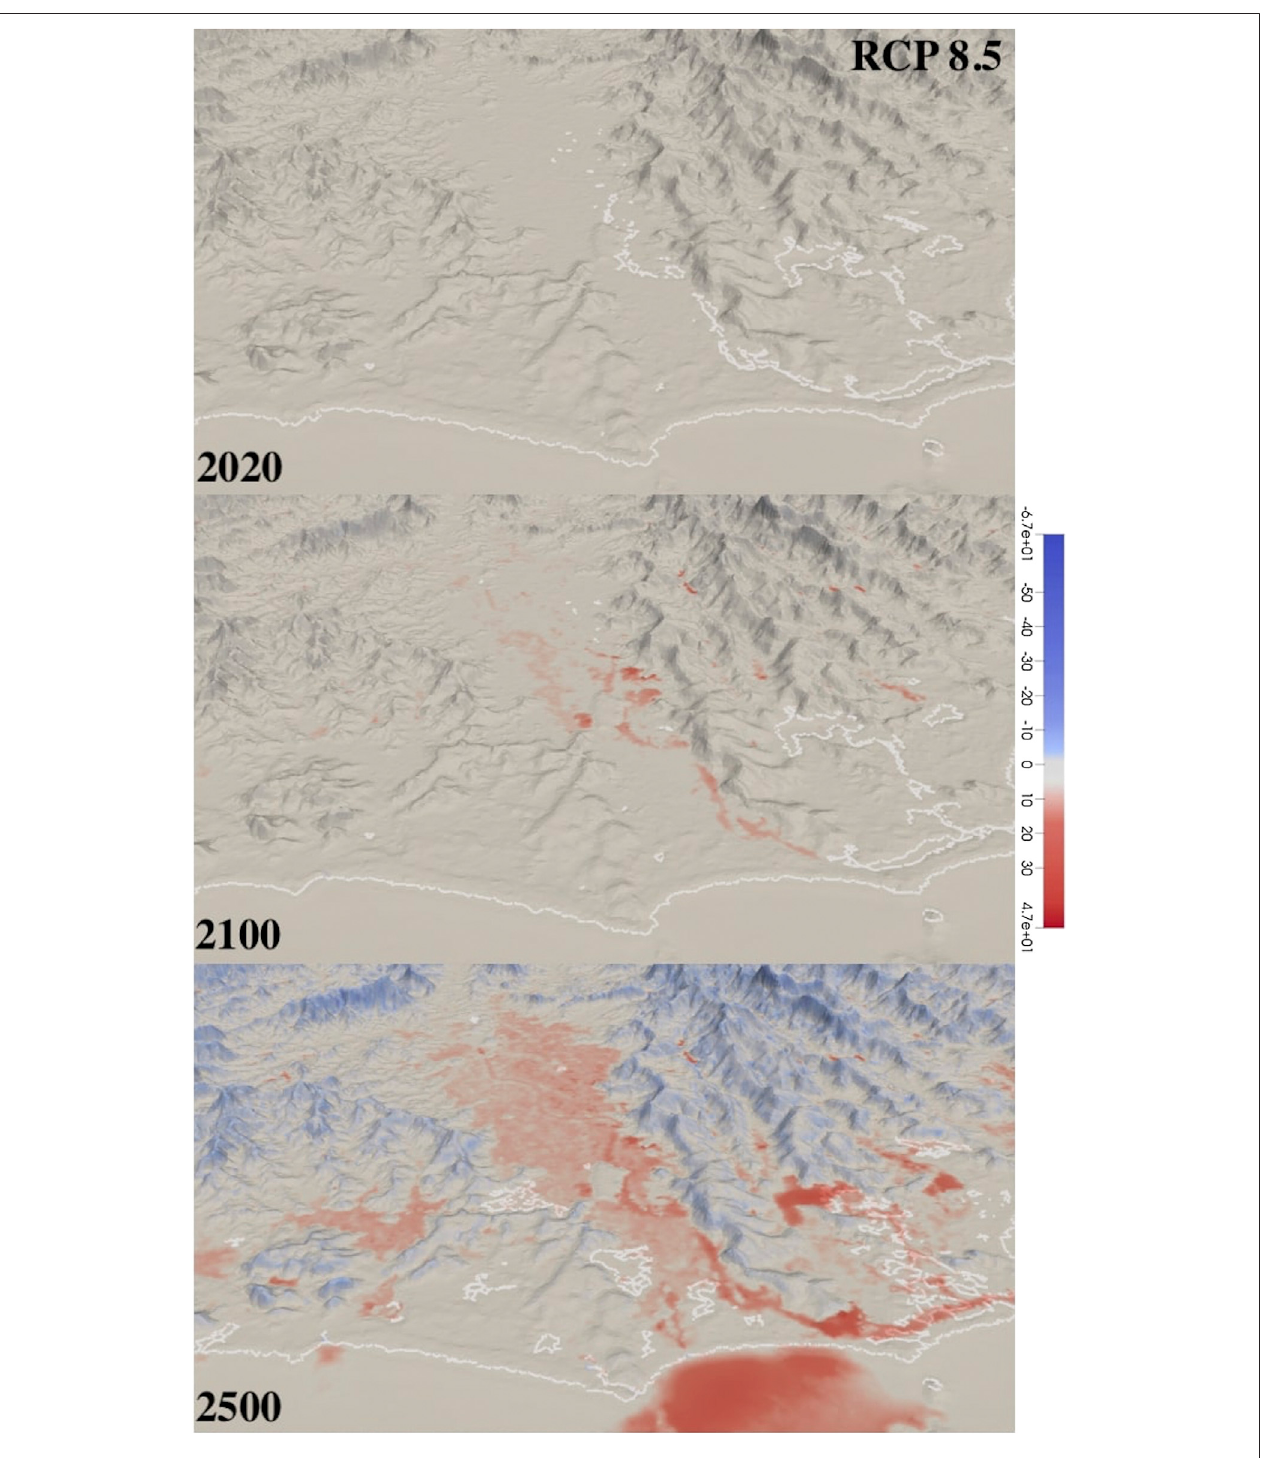
FIGURE 6 | Zoomed in regional visualization of the Tweed Valley fl oodplain region under Representative Concentration Pathways 8.5, illustrating the deposition of ma fi c sediment supply into erosive environments and the heavy accumulation over time, as well as the the impact of sediment supply on local dynamics. Red areas indicate deposition and blue areas indicate erosion (m 2 /a).